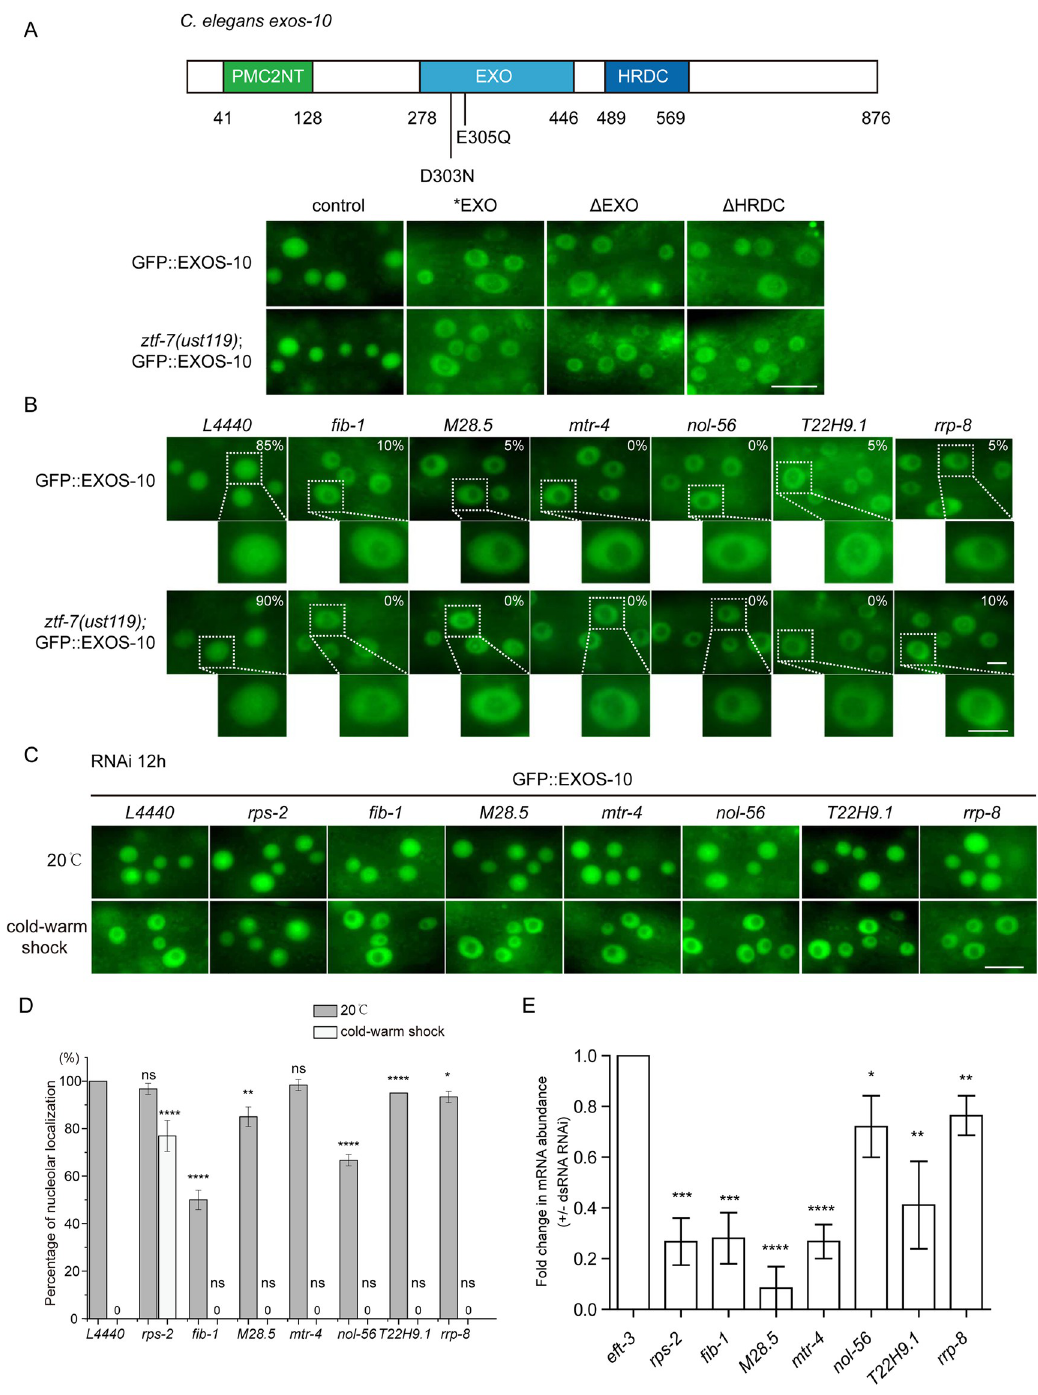
Fig 5. Disruption of EXOS-10 exoribonuclease domains mislocalized EXOS-10 from the nucleolus to the nucleoplasm. (A) (Top) Domain structure of EXOS-10. (Bottom) Images of the animals expressing the indicated EXOS-10 transgenes grown at 20˚C without cold-warm shock. Images were taken from epidermal cells. Scale bars, 10 μ m. EXOS-10 ( � EXO): D303N;E305Q. GFP::EXOS-10( Δ EXO) and GFP::EXOS-10( Δ HRDC) transgenic animals by deleting the EXO domain and HRDC domain, respectively. (B) Images of epidermal cells of animals expressing GFP::EXOS-10 after treatment with RNAi targeting the indicated genes. Bleached embryos carrying EXOS-10 transgenes were grown on RNAi plates for 48 h before being photographed. The percentage of animals with nucleolar-localized GFP::EXOS-10 is indicated. n � 20. Scale bars, 5 μ m. Animals were cultured at 20˚C. (C) Images of epidermal cells of animals expressing GFP::EXOS-10 after treatment with RNAi targeting the indicated